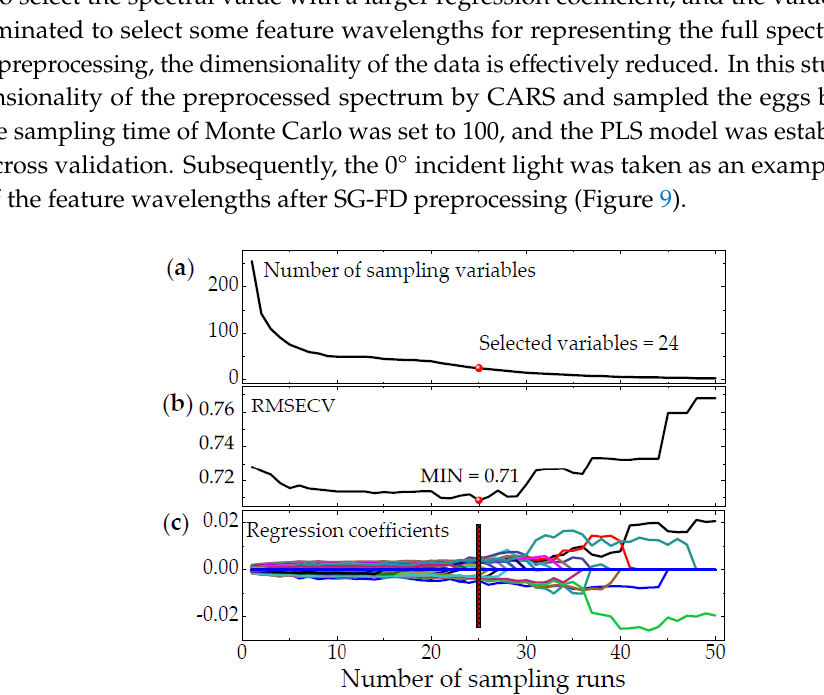
Figure 9. The extraction process of feature wavelength based on competitive adaptive reweighted sampling (CARS) at 0° incident source. ( a ) Number of sampling variables; ( b ) RMSECV; ( c ) Regression coefficient path.